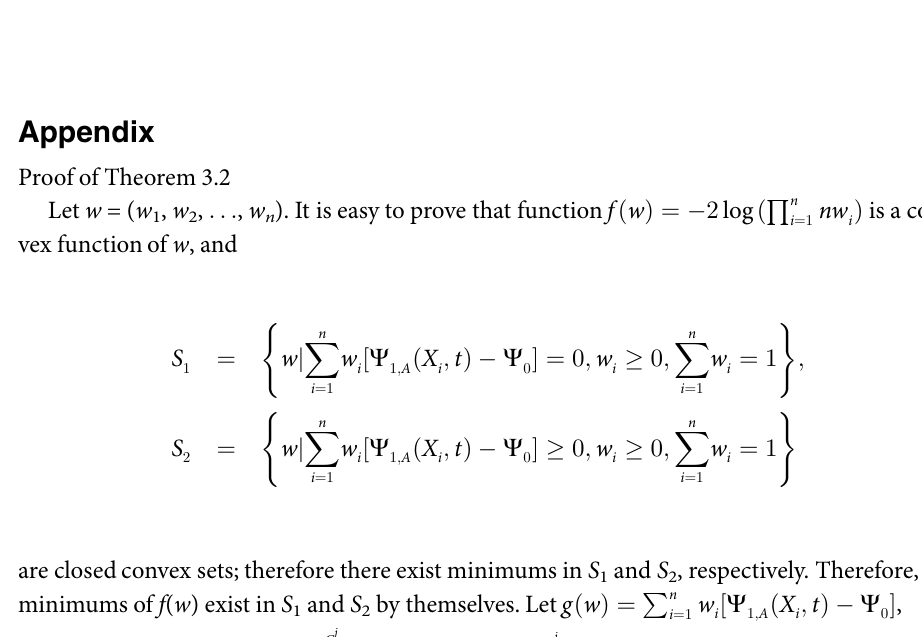
Fig 4. Test H 0 : Ψ 1, A ( t ) (cid:21) Ψ 0 vs H 1 : Ψ 1, A ( t ) < Ψ 0 . Numbers 1, 2, 3, 4, 5, 6, 7, 8, 9, and 0 denote the powers of 0.80, 0.83, 0.86, 0.88, 0.89, 0.90, 0.92, 0.94, 0.96, and 0.98, respectively. The x-coordinate is the sample size, and the y-coordinate is power. The level of significance in the left panel is 0.05, and the level of significance in the right panel is 0.1.